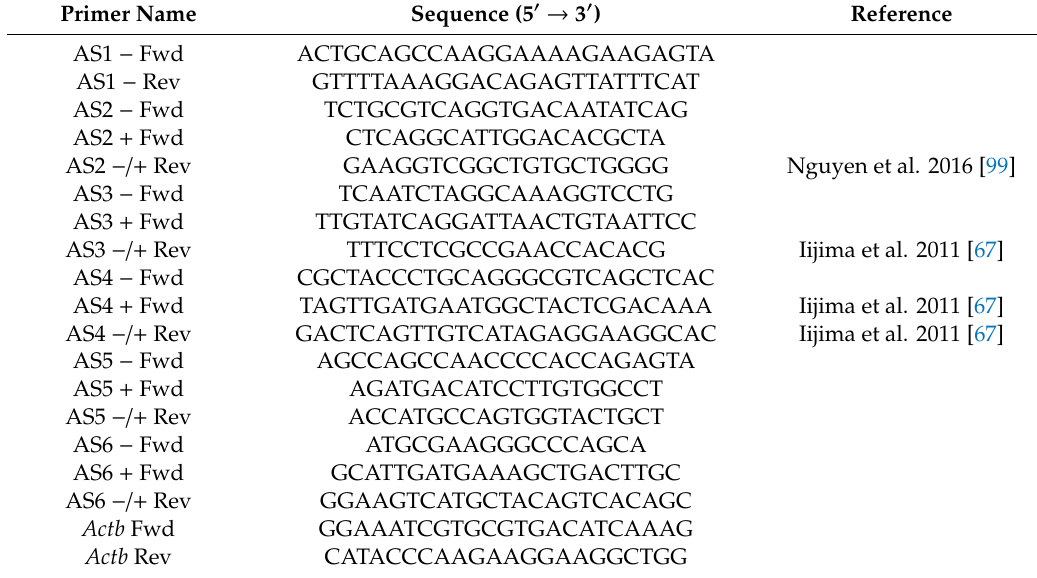
Table 2. List of mouse-specific SYBR ® Green primers utilized in this